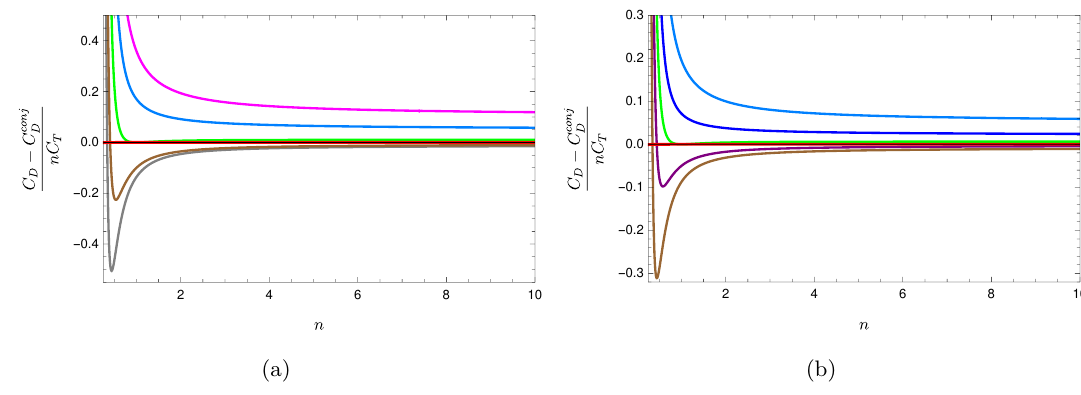
) / ( nC ) as a function of n for fixed chemical potential Figure 9 . Relative difference ( C D − C conj T D in d = 5 (left) and d = 6 (right). The different curves correspond to different chemical potentials, ˜ µ 2 = ± 0 . 04 , ± 0 . 09 , with ˜ µ 2 increasing from bottom to top (we set ‘ = 1 ). We plot the curve ∗ /L with ˜ µ = 0 in green. Note that ˜ µ 2 can be negative, as the chemical potential can take imaginary values. The red curve corresponds to evaluating the SUSY solution. As it can be seen, in this case , at least up to numerical errors of the order 10 − 4 in d = 5 , 6 . C D is exactly C conj D Open